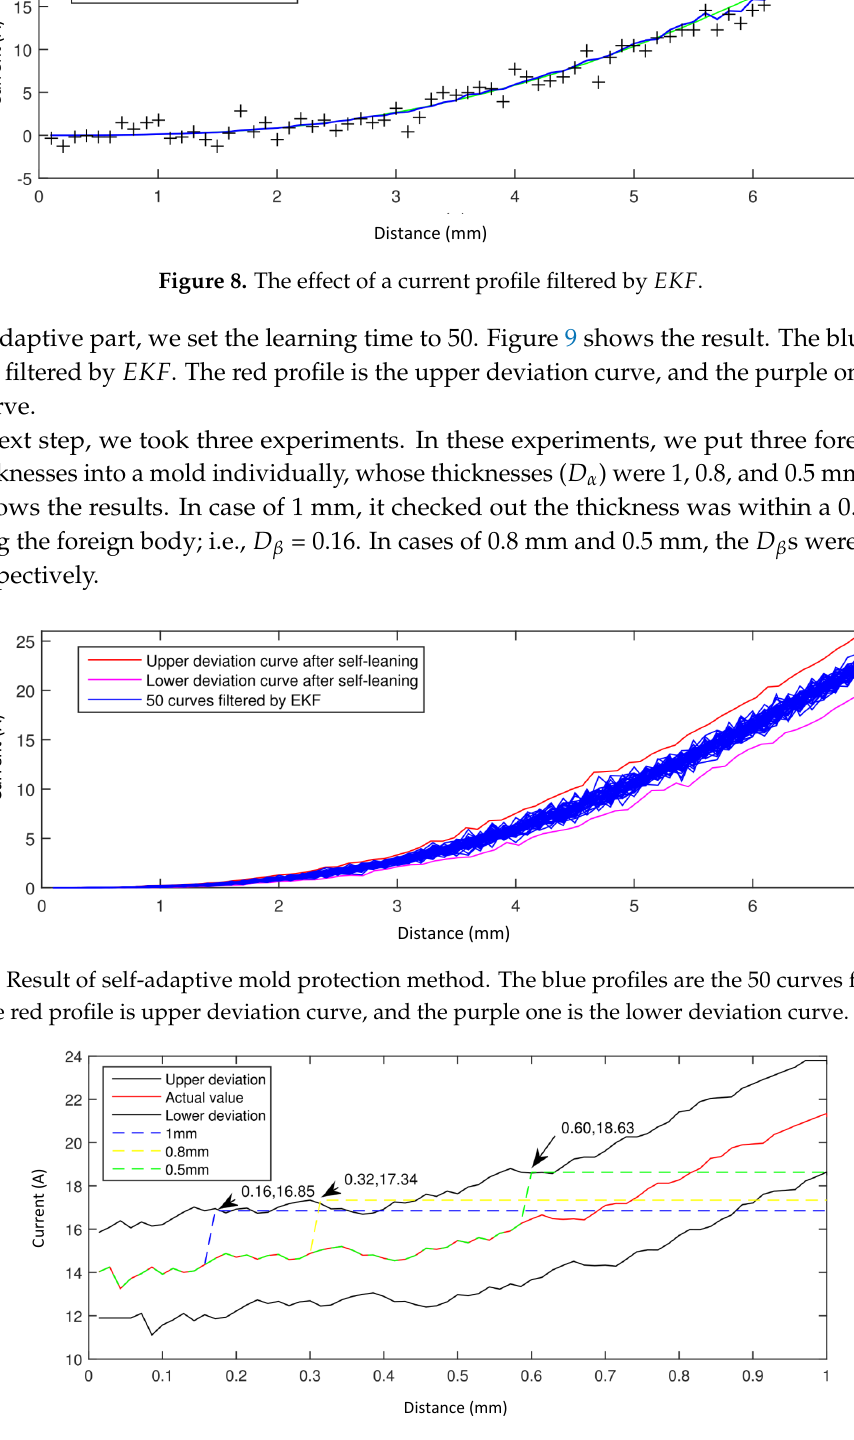
Figure 10. Current profiles when the mold closes with foreign bodies of different